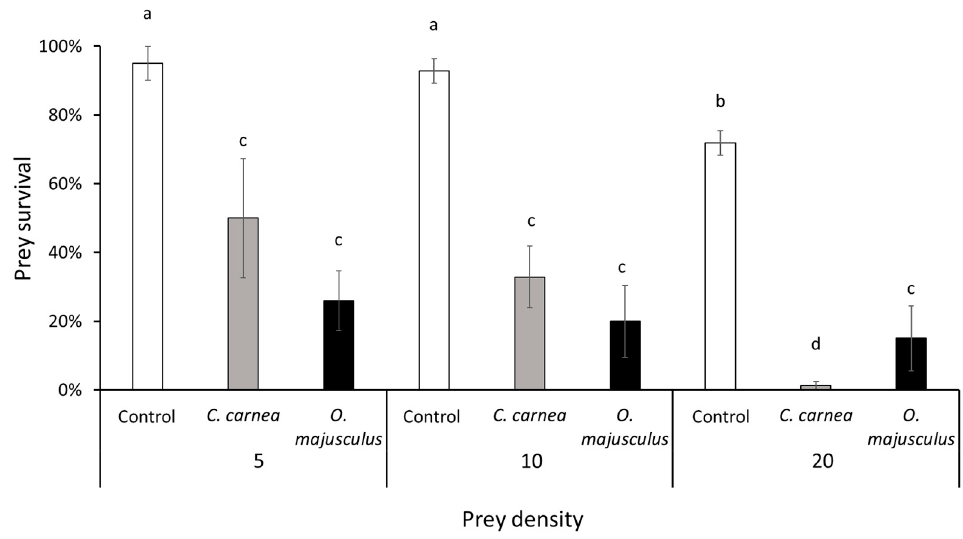
Figure 1. Survival rates (mean ± standard error (SE)) of Erasmoneura vulnerata nymphs offered as prey to Chrysoperla carnea or Orius majusculus in the laboratory. Different letters indicate significant differences at Tukey’s test ( p = 0.05).